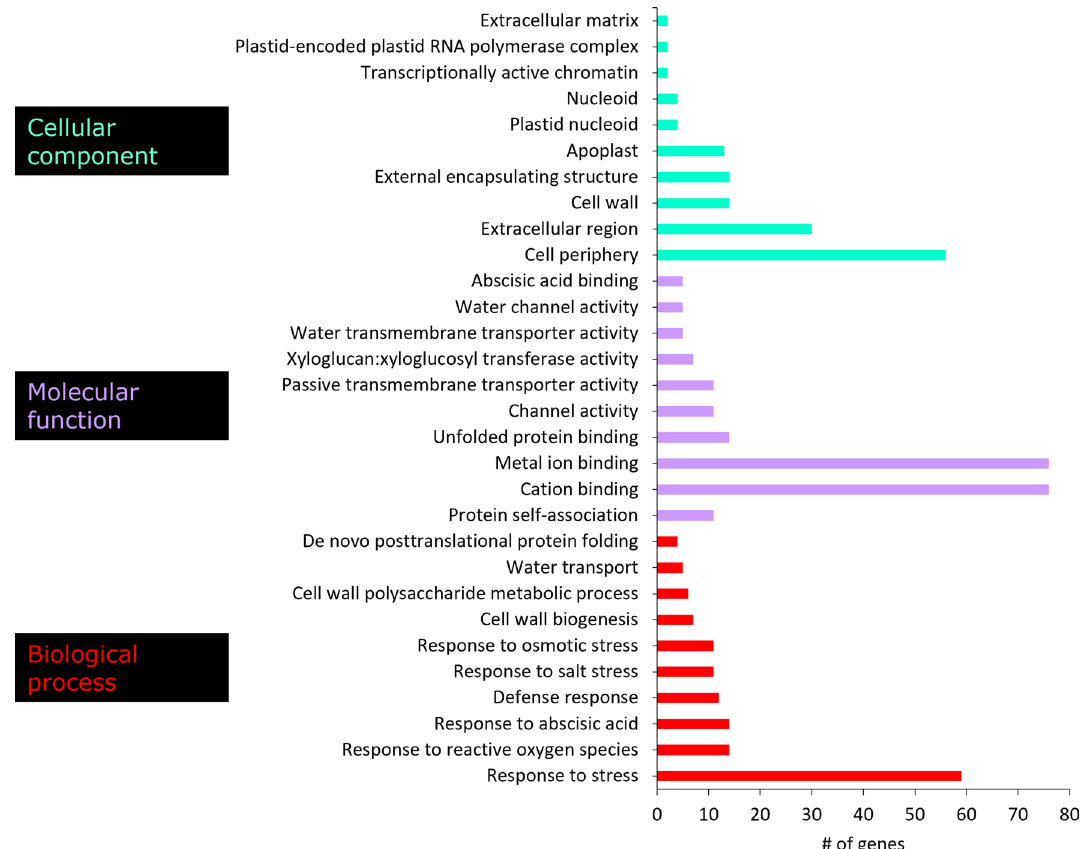
Figure 2. Gene ontologies for the top 10 enriched factors for Cellular Component (CC), Molecular Function (MF), and Biological Process